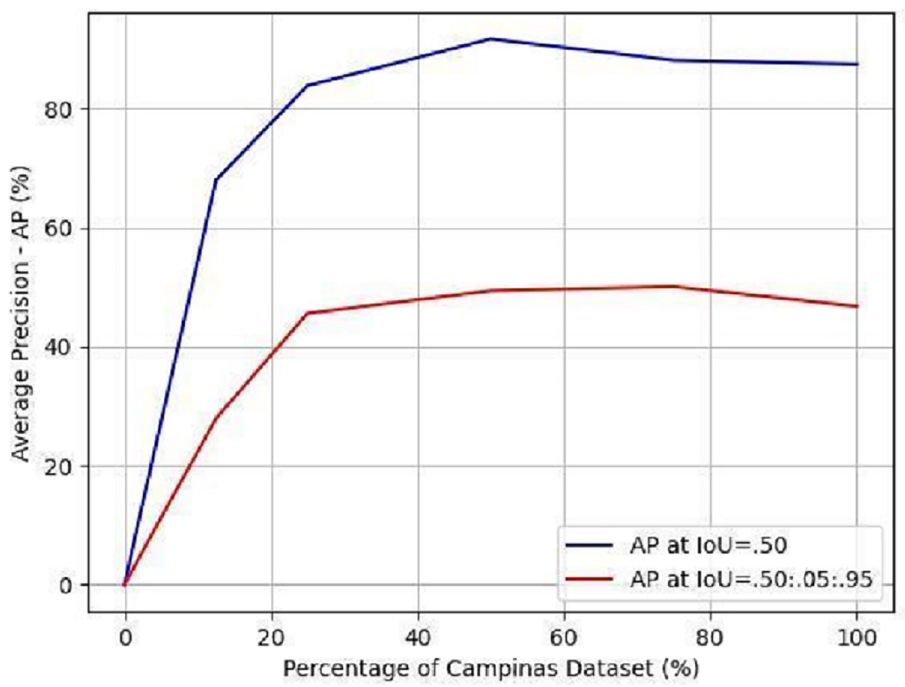
Fig 5. Influence of the Campinas dataset on the fine-tuning. The higher the percentage of the Campinas dataset used, the better the performance of the neural network in terms of the AP metric. To evaluate our object detector, we used two different IoU thresholds: 0.5 (blue curve) and 0.5:0.05:0.95 (the average AP for IoU threshold from 0.5 to 0.95 with a step size of 0.05; red